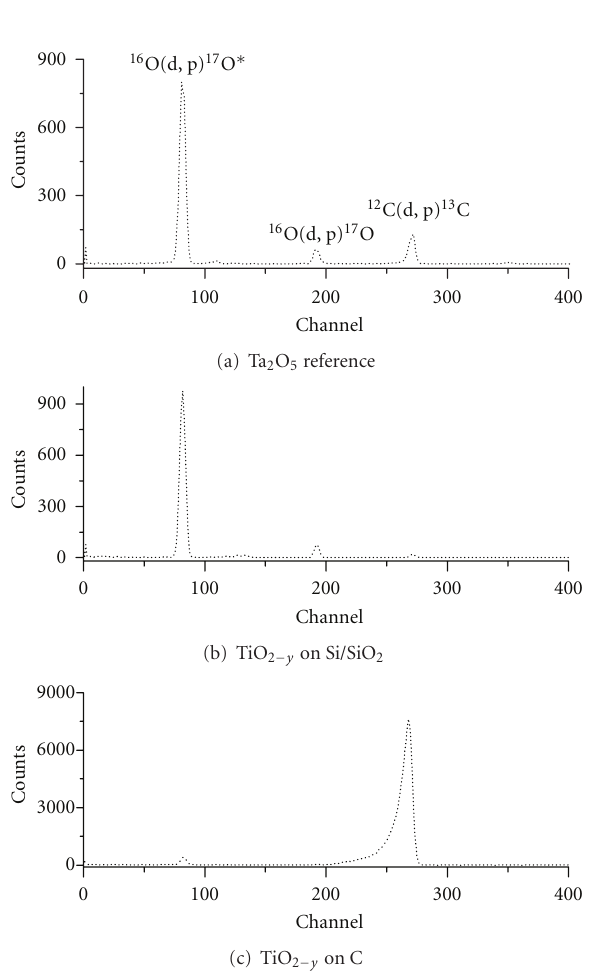
Figure 4: The NRA spectra of (a) Ta 2 O 5 reference sample; (b) TiO 2 − y thin film deposited on thermally oxidized Si wafer (Si/SiO 2 ) and (c) TiO 2 − y on carbon foil C. The nuclear reactions corresponding to three peaks in the spectra are